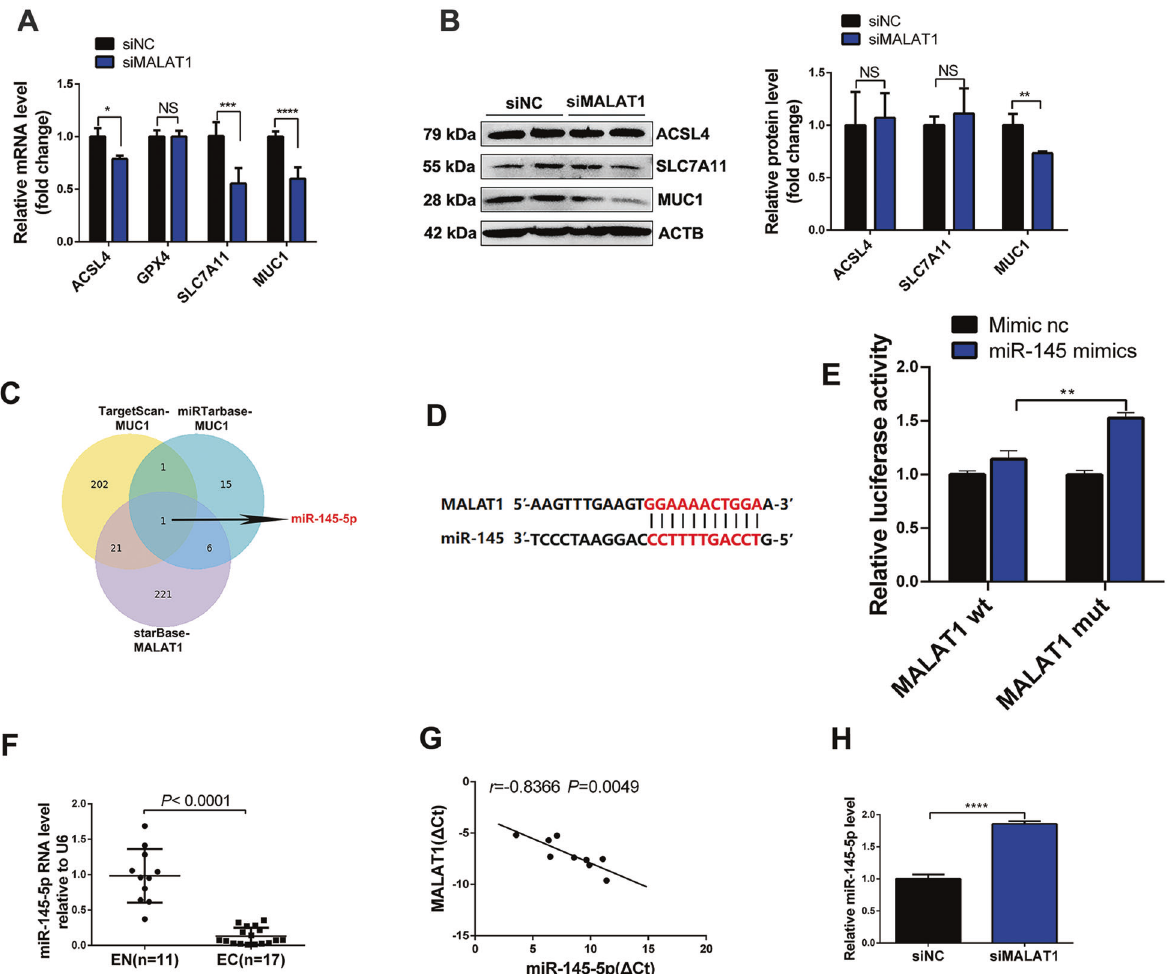
Fig. 4 MALAT1 acts as a ceRNA for miR-145-5p. A qRT-PCR analysis was performed to detect the mRNA expression of ACSL4, GPX4, SLC7A11, and MUC1 in EESCs transfected with siMALAT1 (50 nM) or siNC (50 nM) for 24 h. B Western blot analysis was performed to detect the protein expression of ACSL4, SLC7A11, and MUC1 in EESCs transfected with siMALAT1 (50 nM) or siNC (50 nM) for 48 h. C Venn graph of MALAT1- targeted miRNAs predicted by starBase and miRNAs predicted by TargetScan and miRTarBase to target MUC1. D The predicted binding sites between miR-145-5p and MALAT1 are shown. E Luciferase activities were assessed in 293T cells cotransfected with the MALAT1 mutant (MALAT1 mut) and miR-145-5p mimics or cotransfected with MALAT1 wild type (MALAT1 wt) and miR-145-5p mimics. F qRT-PCR analysis was performed to detect the expression of miR-145-5p in 17 EC tissues and 11 EN tissues. G The correlation between the expression of MALAT1 and miR-145-5p was analyzed using the Pearson ’ s test ( r < 0 denotes a negative correlation). H miR-145-5p expression after MALAT1 silencing was determined using qRT-PCR. All data are shown as the mean ± SD of three independent experiments (NS is nonsigni fi cant, * P < 0.05, ** P < 0.01, *** P < 0.001, **** P < 0.0001). Statistical signi fi cance was calculated using Student ’ s t test. EC ectopic endometrial, EN normal